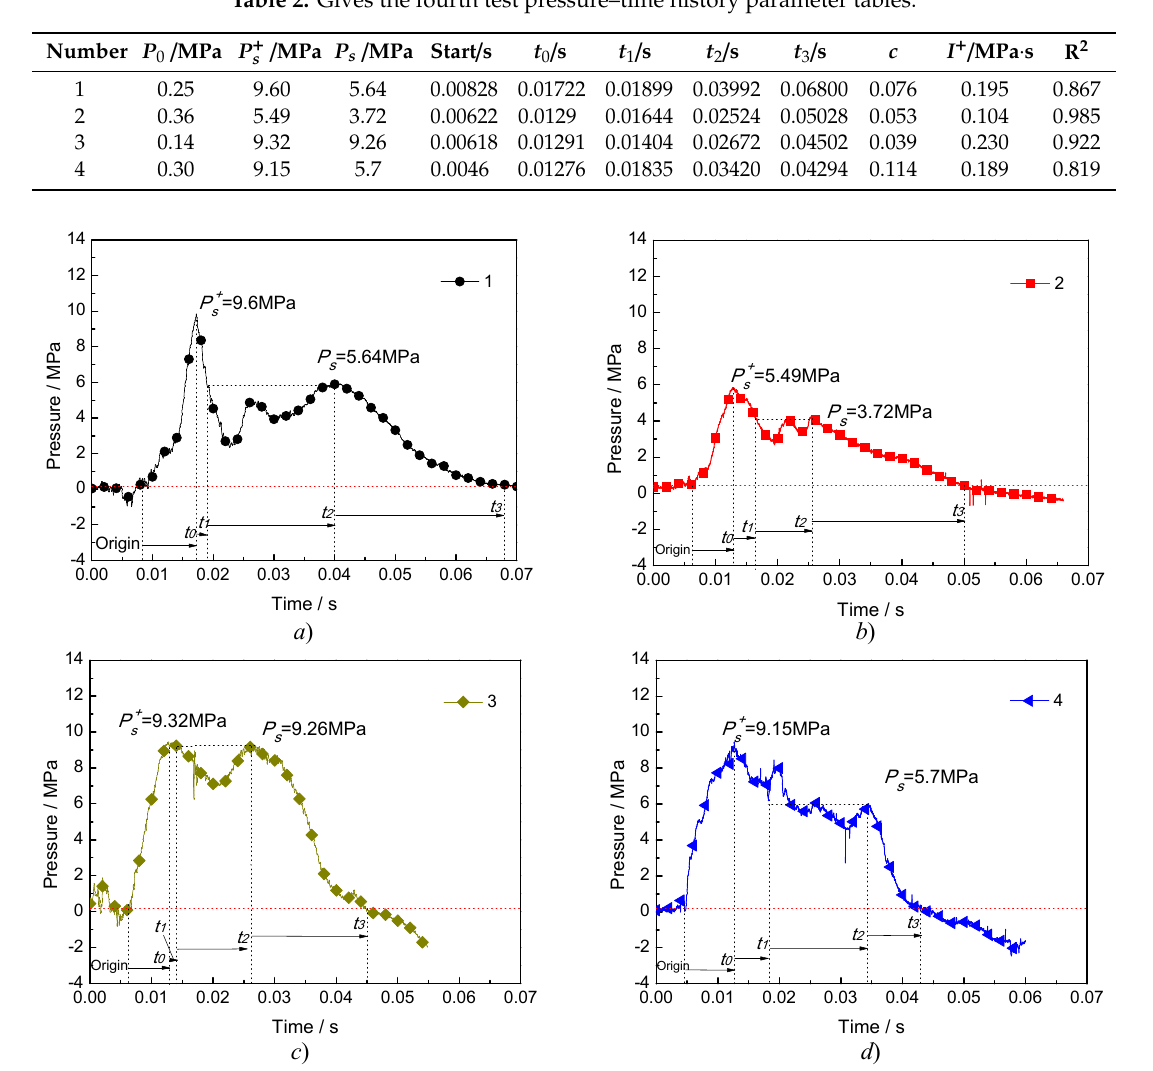
Figure 8. Pressure–time curve at a certain distance outside the blasting tube in four tests.